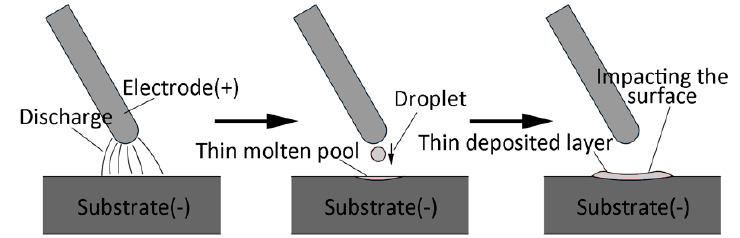
Figure 4. Droplet transition process.